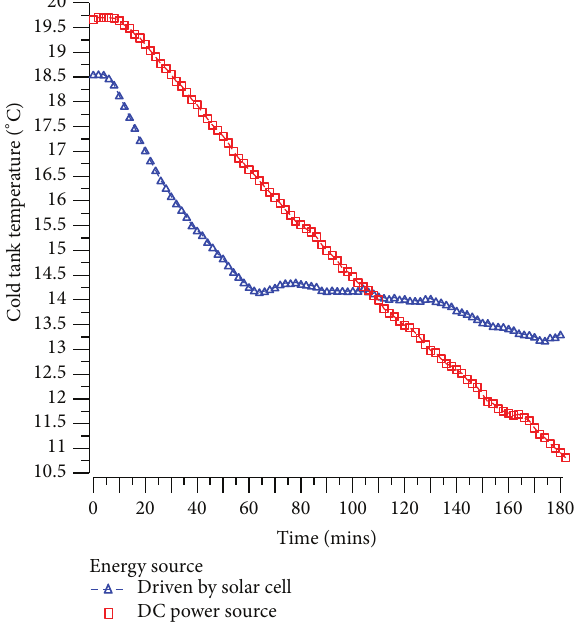
Figure 8: The cold tank temperatures of the thermoelectric system by DC source and solar cells.